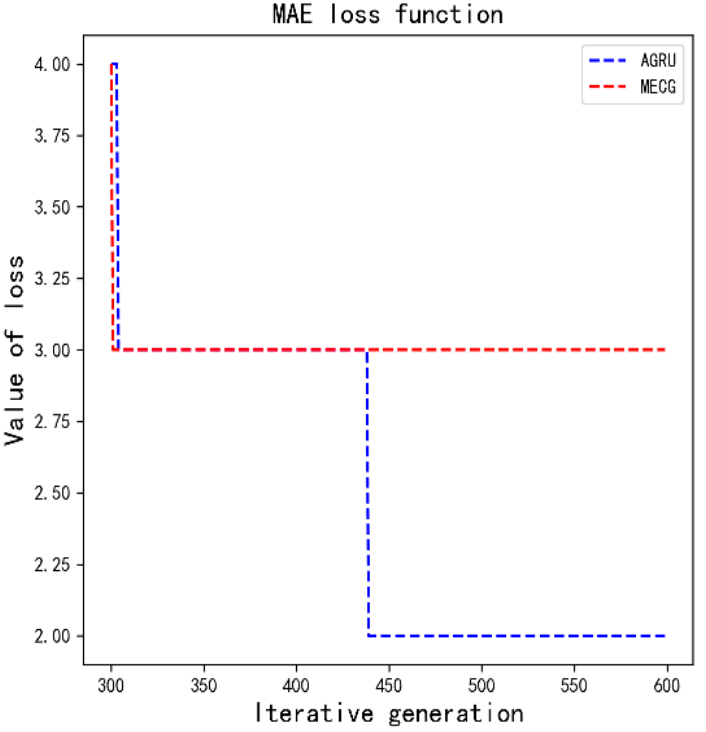
Figure 11. The convergence rate of AGRU and MECG models after 300 iterations.